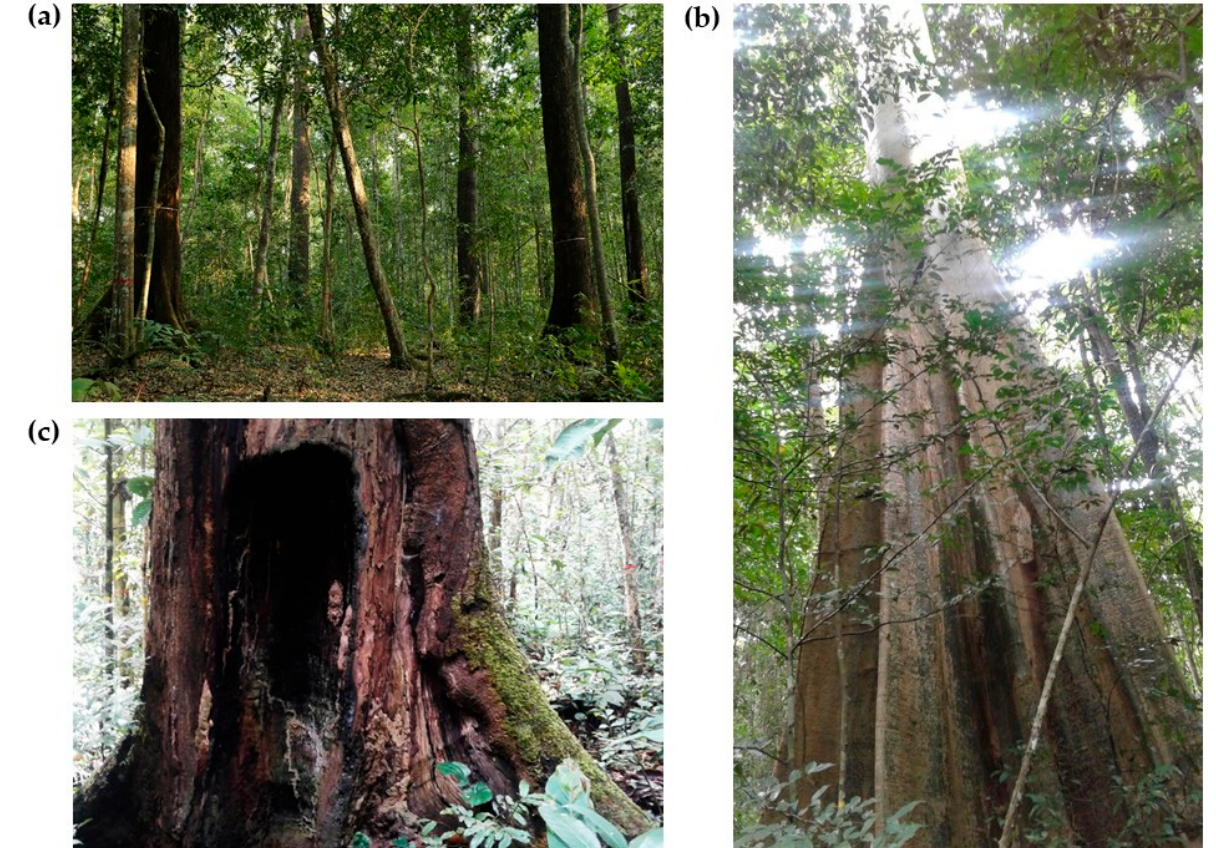
Figure 2. Huai Kha Khaeng Forests Dynamics Plot, Thailand. ( a ) tree species composition; ( b ) a large tree with buttress roots; ( c ) a large fire scar from repeated burns on Hopea Odorata .